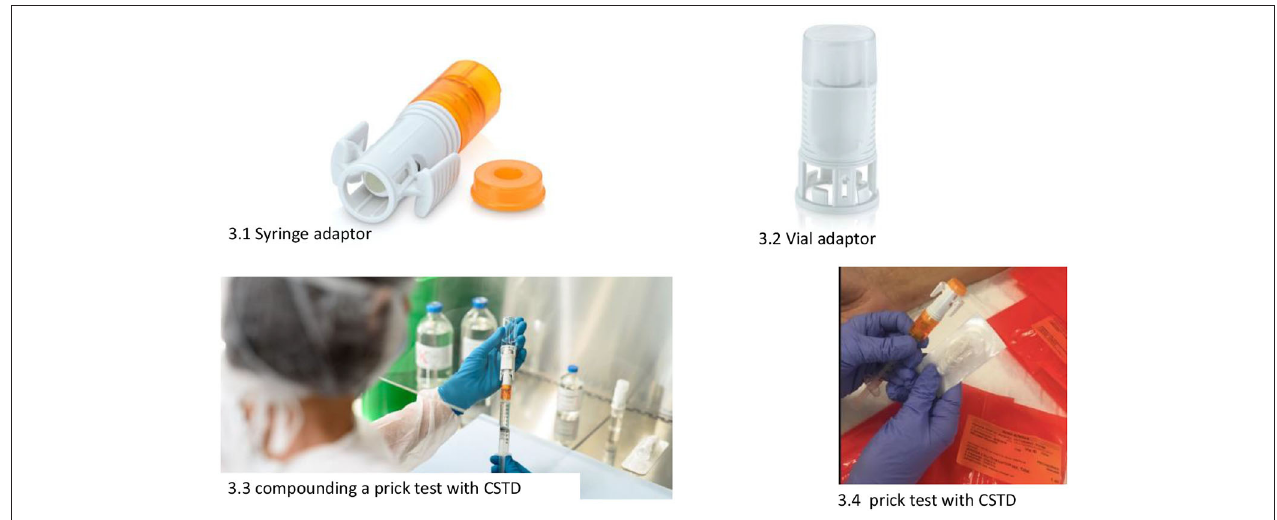
FIGURE 1 | CSTDs: Tevadaptor® (photos used with the permission of the manufacturer).